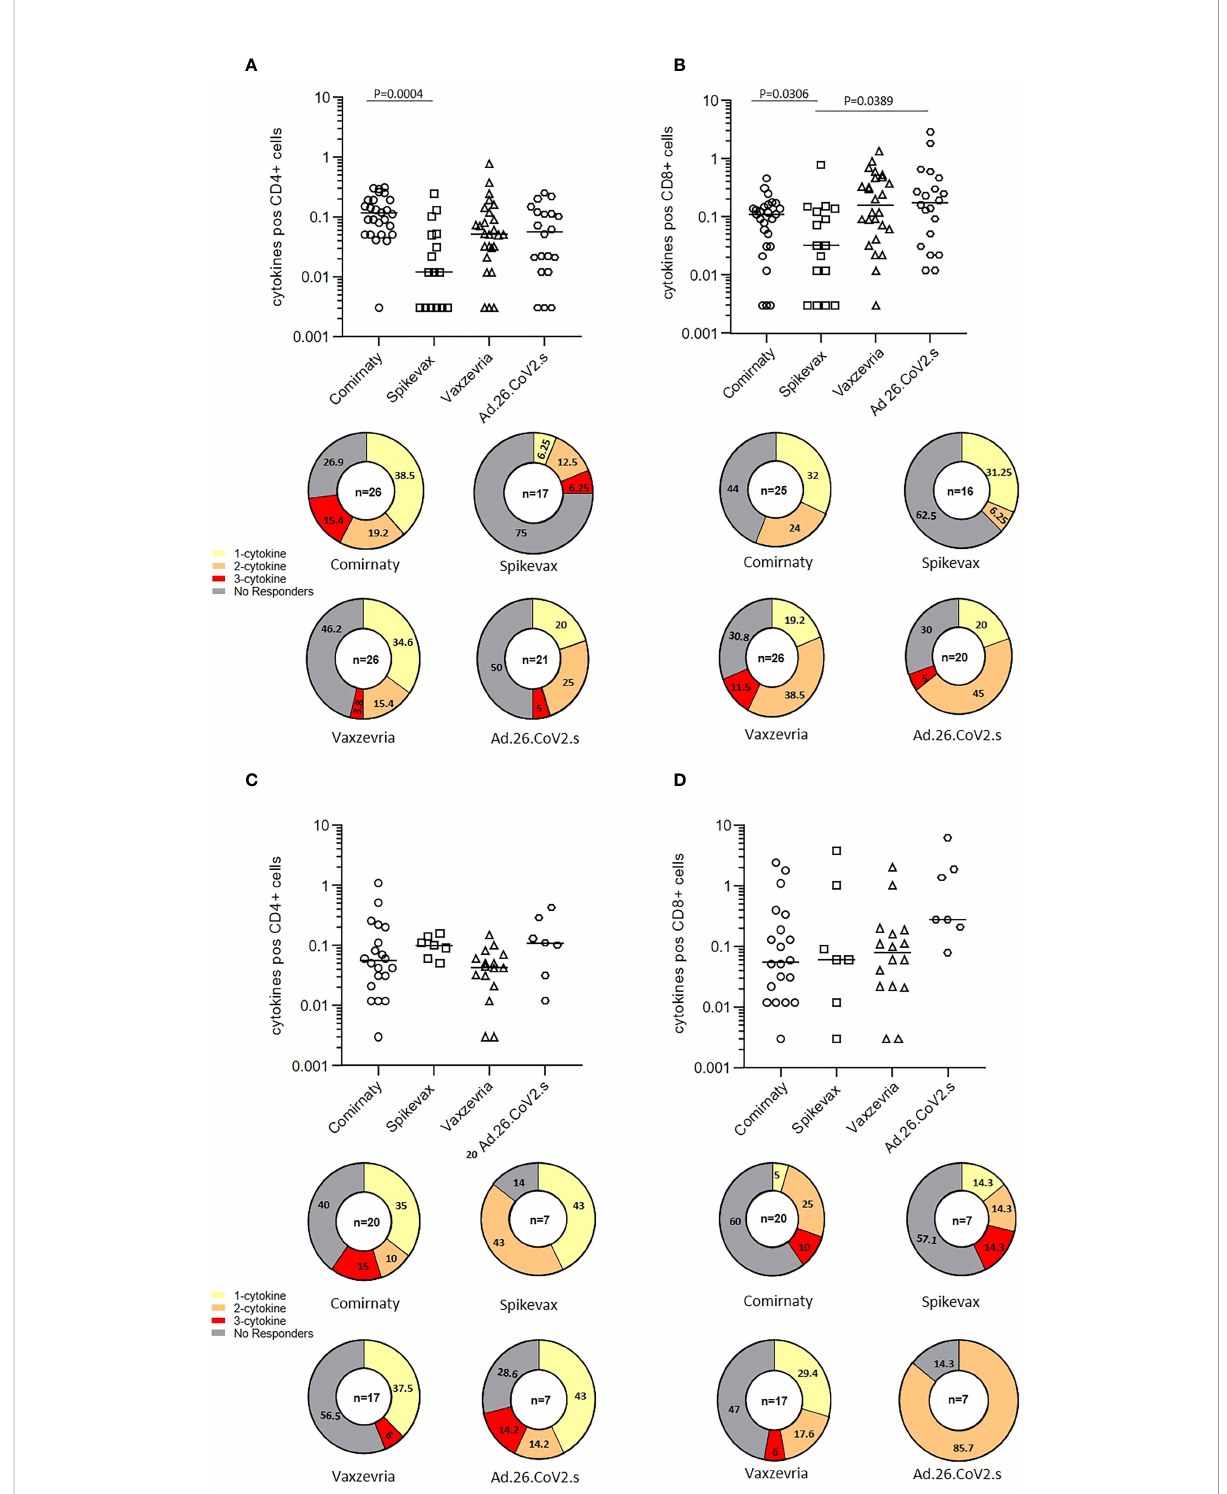
FIGURE 5 T-cell mediated immune response in COVID-19 vaccinees 6 months after fi rst immunization. The frequencies of CD4+ and CD8+ T cells producing IFN- g , TNF a and IL-12 in healthy adults (A, B) and frail elderly subjects (C, D) in response to in vitro stimulation with Spike are shown as total cytokine response. Statistical differences among types of vaccine were calculated by the Wilcoxon test. Pie diagrams show the frequencies of non-responding T cells or T cells producing 1 to 3 cytokines